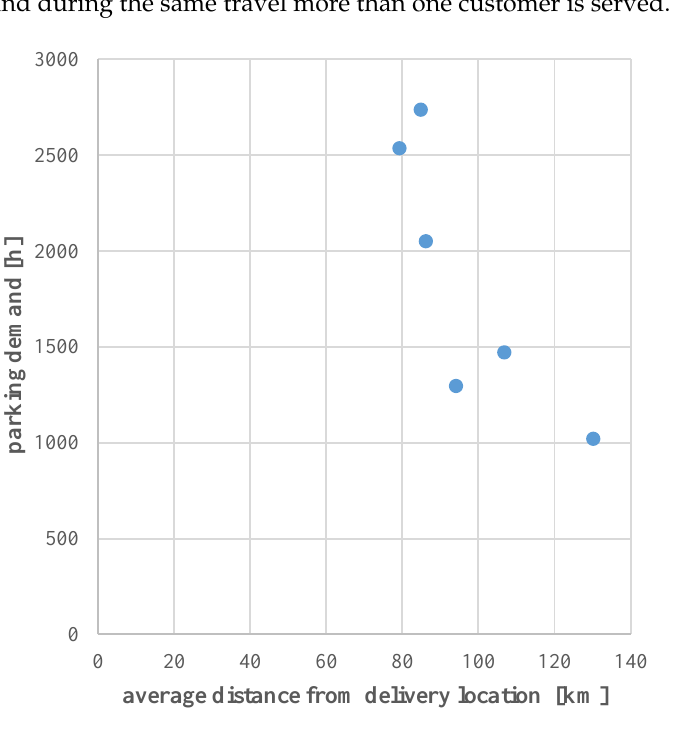
Figure 6. Parking demand vs. distance of delivery location.